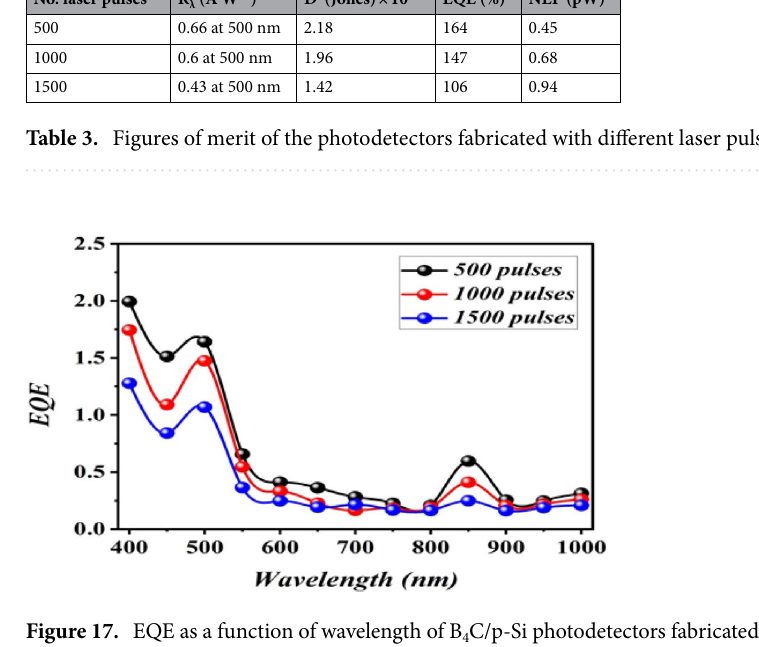
Figure 17. EQE as a function of wavelength of B 4 C/p-Si photodetectors fabricated at different number of laser pulses at bias voltage of 5